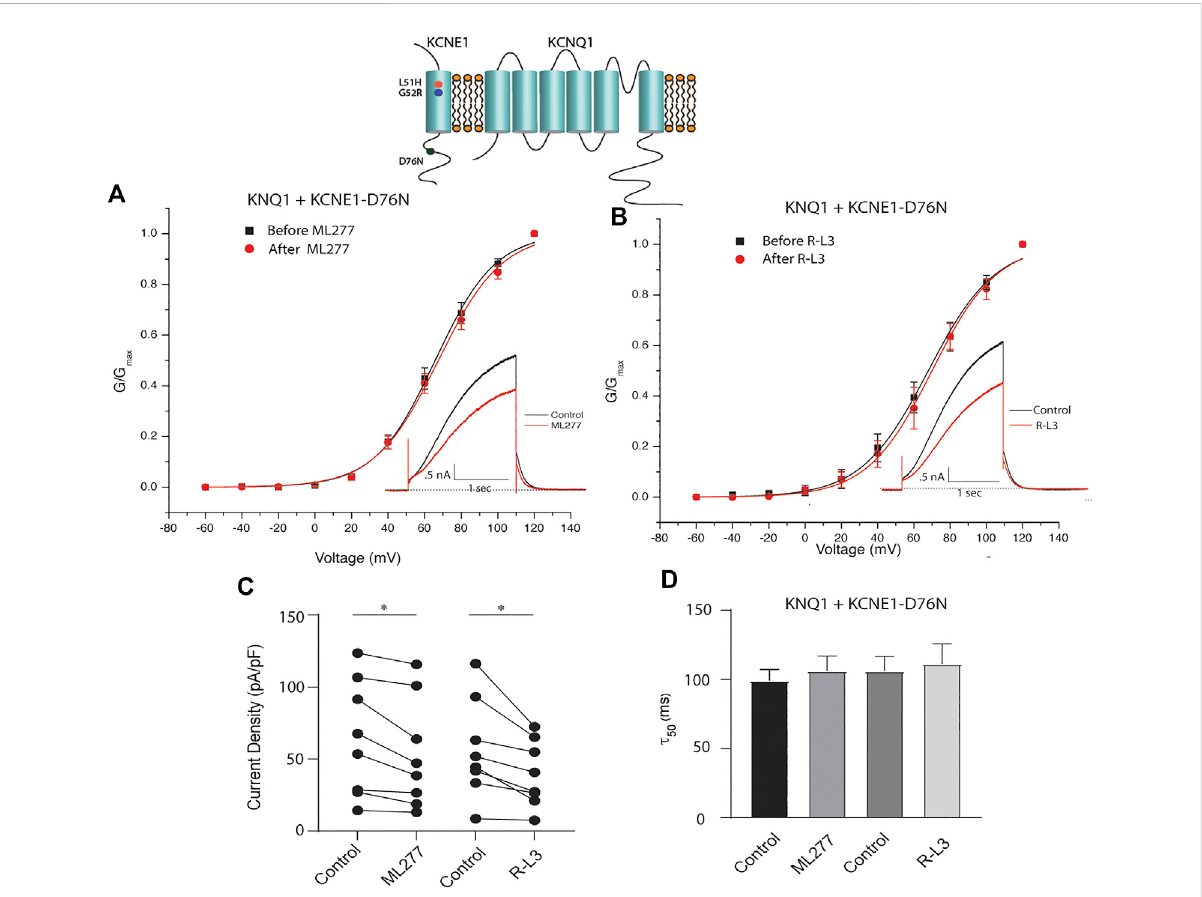
FIGURE 3 ML277 andR-L3do notenhancechannelactivitycarried byKCNQ1 expressedwith theD76NmutantKCNE1subunit. (A) .Conductancevoltage curves of KCNQ1-D76N channels in the absence (black) and presence (red) of 1 μ M ML277. (B) . Conductance voltage curves of KCNQ1-D76N channels in the absence (black)and presence (red) of 1 μ MR-L3. (C) . Tail current density measured at − 40 mV in the absence (control) and presence of 1 μ M ML277 and 1 μ M R-L3. Data from individual experiments are connected by straight lines. (D) . Deactivation time constants measured at − 40 mV in the absence (control) and presence of 1 μ M ML 277 and 1 μ M